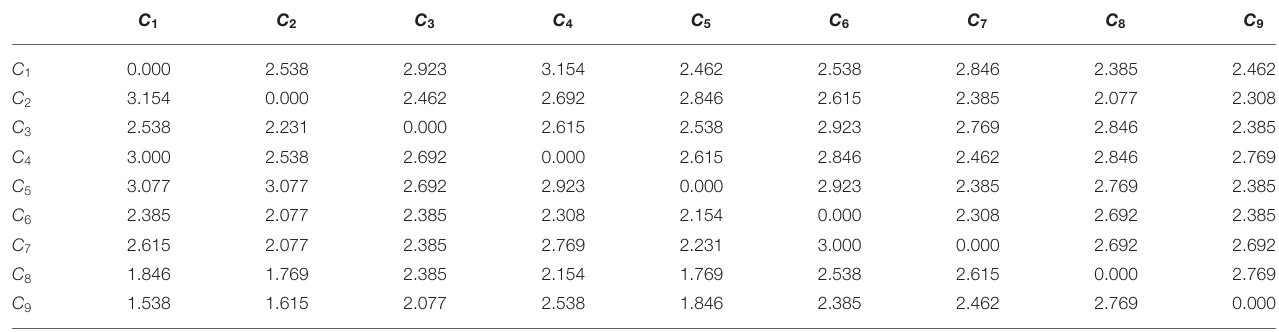
TABLE 3 | The initial influence matrix.